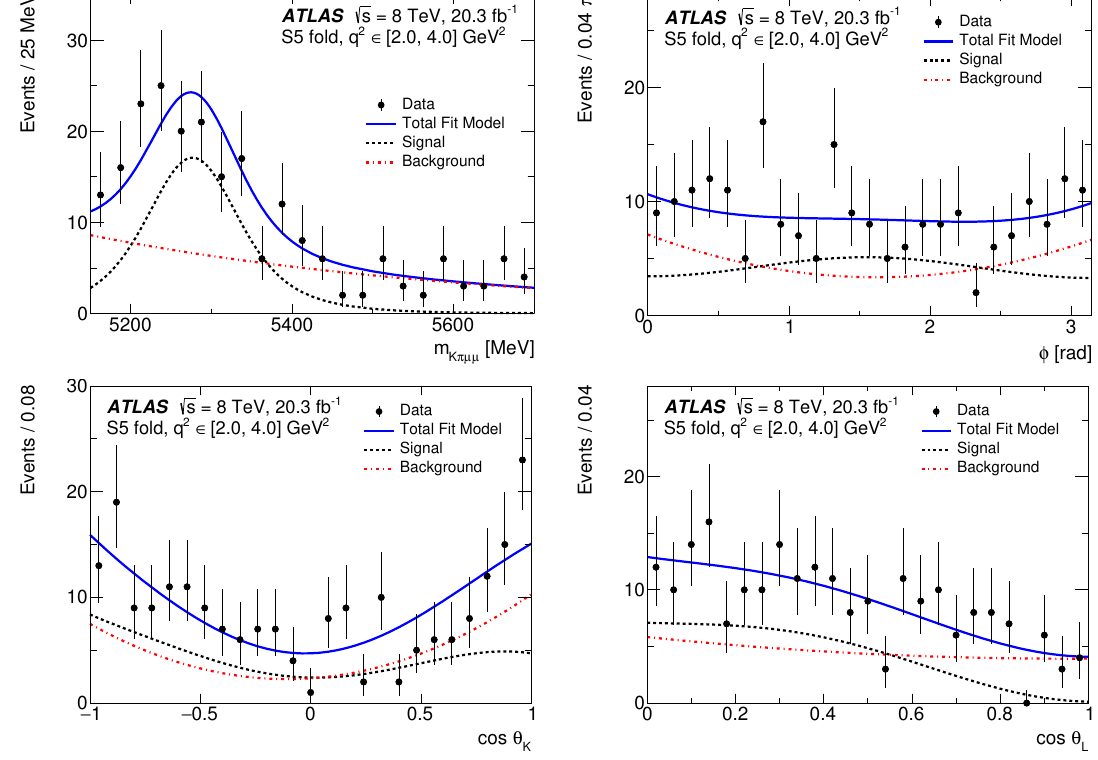
Figure 5 . The distributions of (top left) m , (top right) (cid:30) , (bottom left) cos (cid:18) , and (bottom K(cid:25)(cid:22)(cid:22) K right) cos (cid:18) obtained for q 2 2 [2 : 0 ; 4 : 0] GeV 2 . The (blue) solid line is a projection of the total pdf, L the (red) dot-dashed line represents the background, and the (black) dashed line represents the signal component. These plots are obtained from a (cid:12)t using the S folding 5